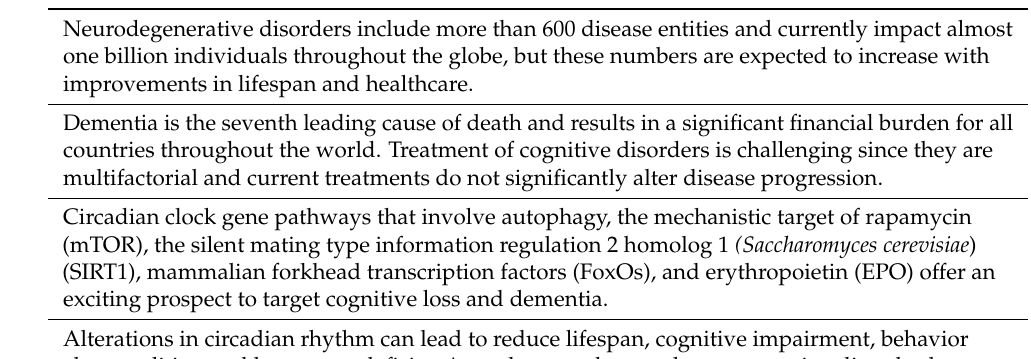
Table 1. Highlights—Cognitive Impairment and Dementia: Circadian Clock Gene Pathways. Neurodegenerative disorders include more than 600 disease entities and currently impact almost one billion individuals throughout the globe, but these numbers are expected to increase with improvements in lifespan and